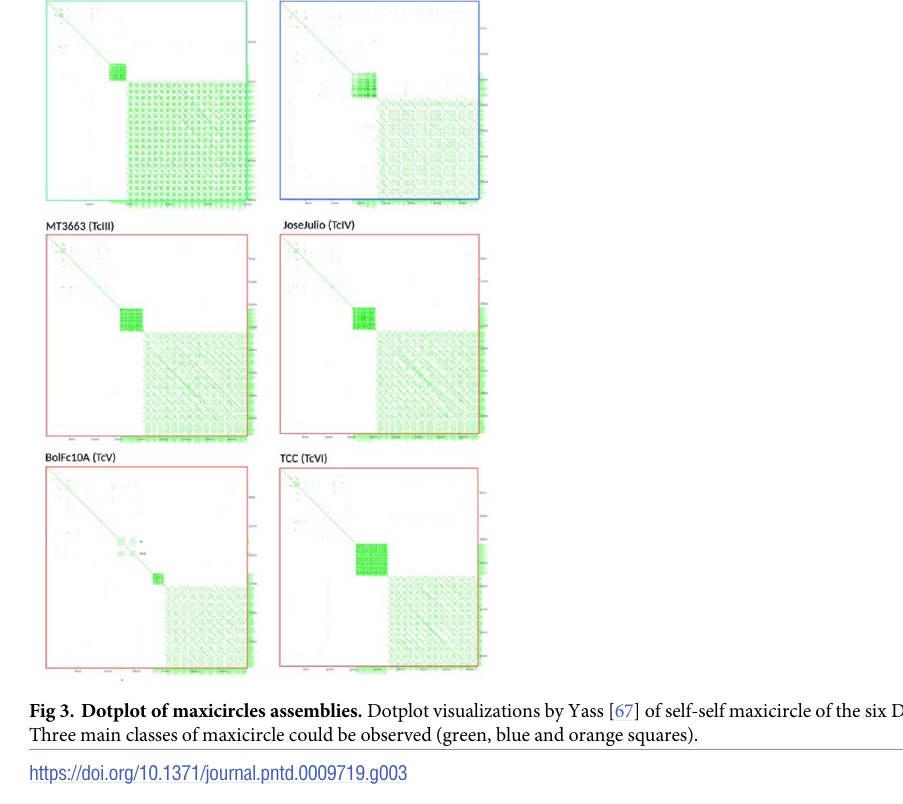
PLOS NeglectedTropical Diseases | https://doi.org/10.1371/journal.pntd.0009719 August 26,